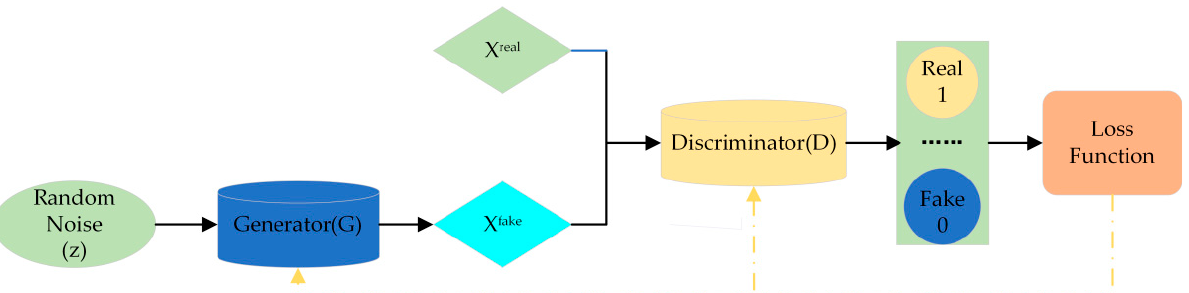
Figure 7. Basic structure of GAN model.